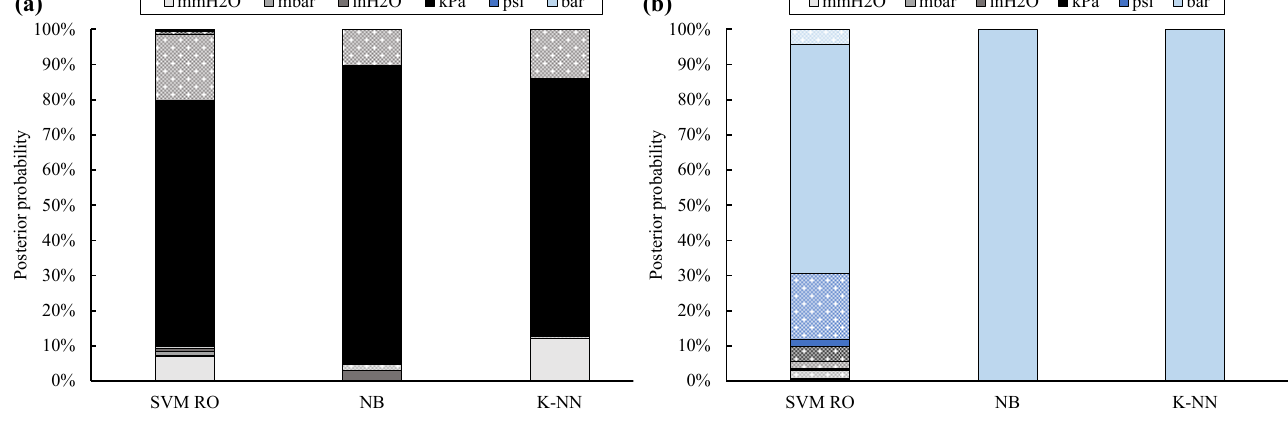
Figure 7. Posterior probability for twelve UOMs: site cross-validation by means of non-filtered data (full bar: absolute UOMs, dotted bar: gauge UOMs; kPa absolute sites ( a ), bar absolute site ( b )).